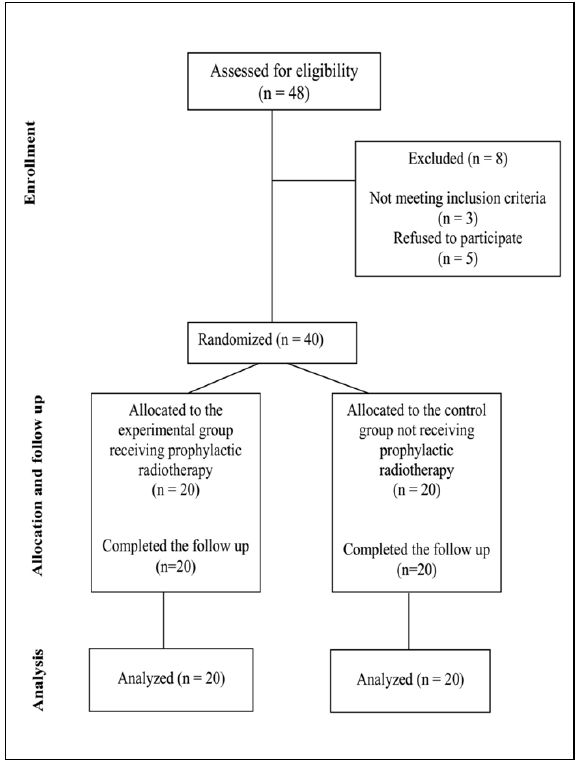
Figure 1. The CONSORT flow diagram of study